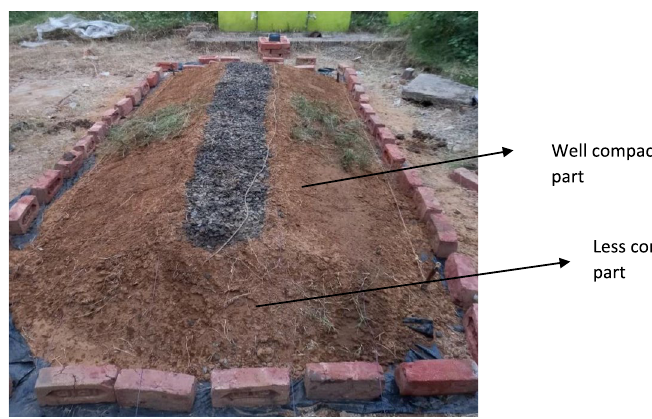
Fig. 9 Grass placed over a length on both sides of compacted